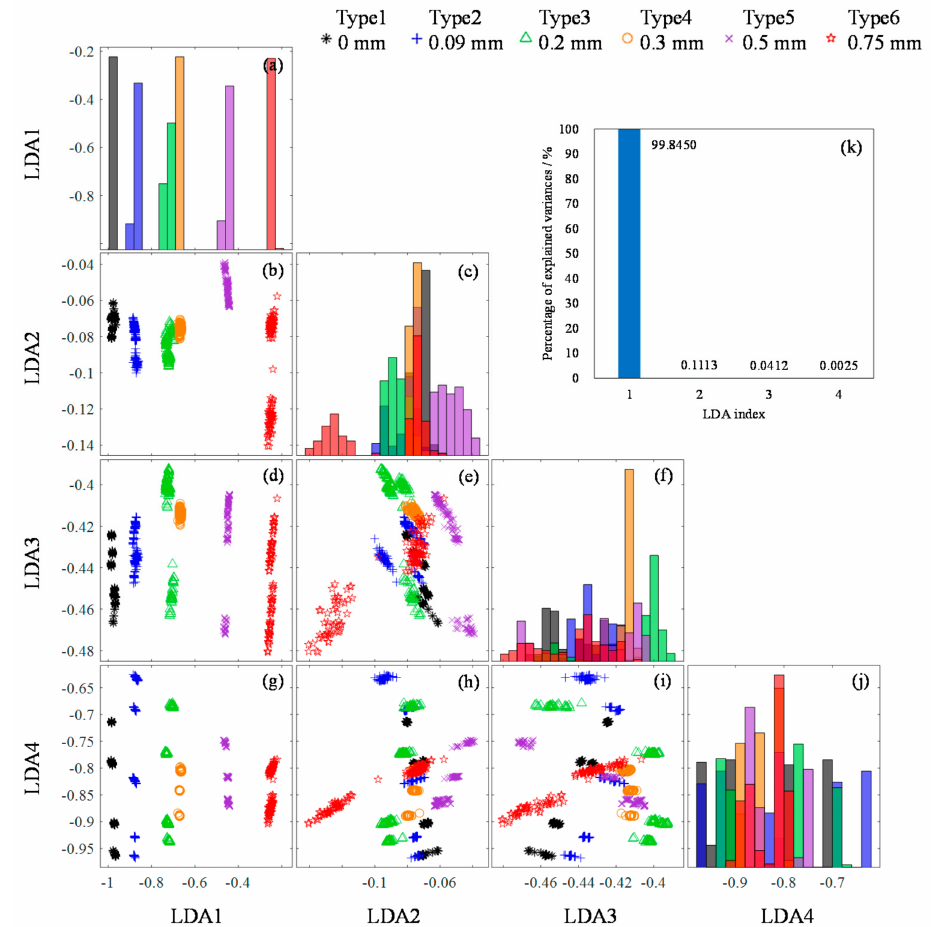
Figure 12. Analysis result of LDA. The matrix diagram of LDA is composed of ( a–j ). In the matrix of scatter plots ( b , d , e , g – i ), the horizontal and vertical coordinates are the pairwise combinations of LDA1, LDA2, LDA3, and LDA4. The diagonal plots are histograms ( a , c , f , j ), indicating the distribution on a separate variable of LDA1, LDA2, LDA3, LDA4 respectively. The color of each data depends on the types of faults. The histogram ( k ) shows the contributing rate of LDA